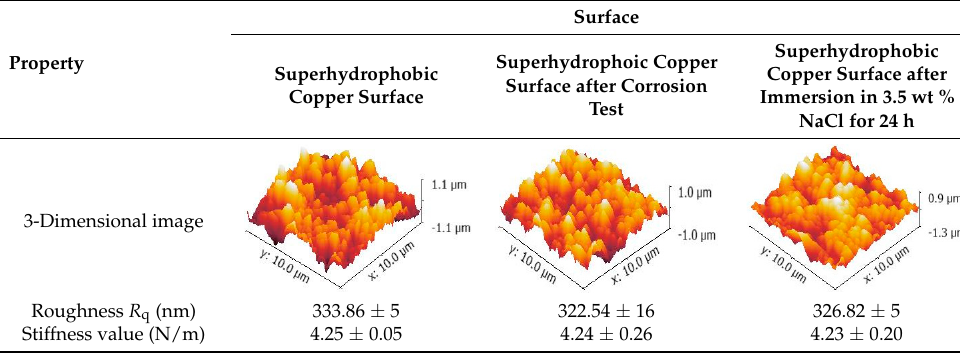
Table 2. AFM image, roughness, and stiffness of the superhydrophobic copper surfaces. Surface Property